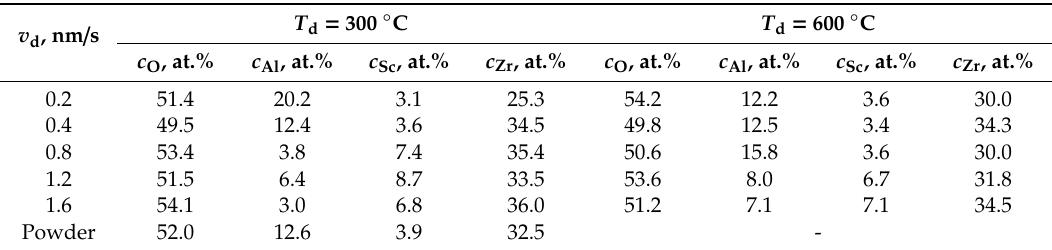
Table 1. EDS analysis results of ScAlSZ thin films, ( v d —deposition rate, T d —substrate temperature during deposition, and c —atomic concentration).